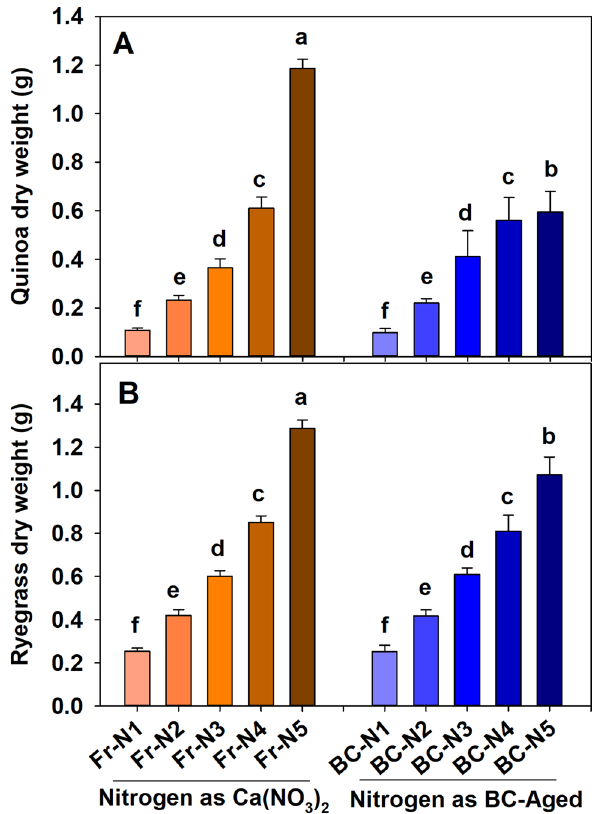
Figure 1. Effect of different nitrogen sources [(CaNO 3 ) 2 and N captured in BC-aged] and application levels (N-1 = 0, N-2 = 44, N-3 = 88, N-4 = 176 and N-5 = 352 kg ha −1 ) on quinoa and ryegrass dry matter production under controlled conditions (means + s.d., n = 4). The dry matter of ryegrass is the sum of two cuts harvested at 30 days interval. Note that the y-axis scales of ( A ) and ( B ) are different, based on the respective dry matter yield production from quinoa and ryegrass. Different letters on top of the bars indicate significant differences in biomass due to the respective N sources and N levels following two-way ANOVA (Tukey test, P <